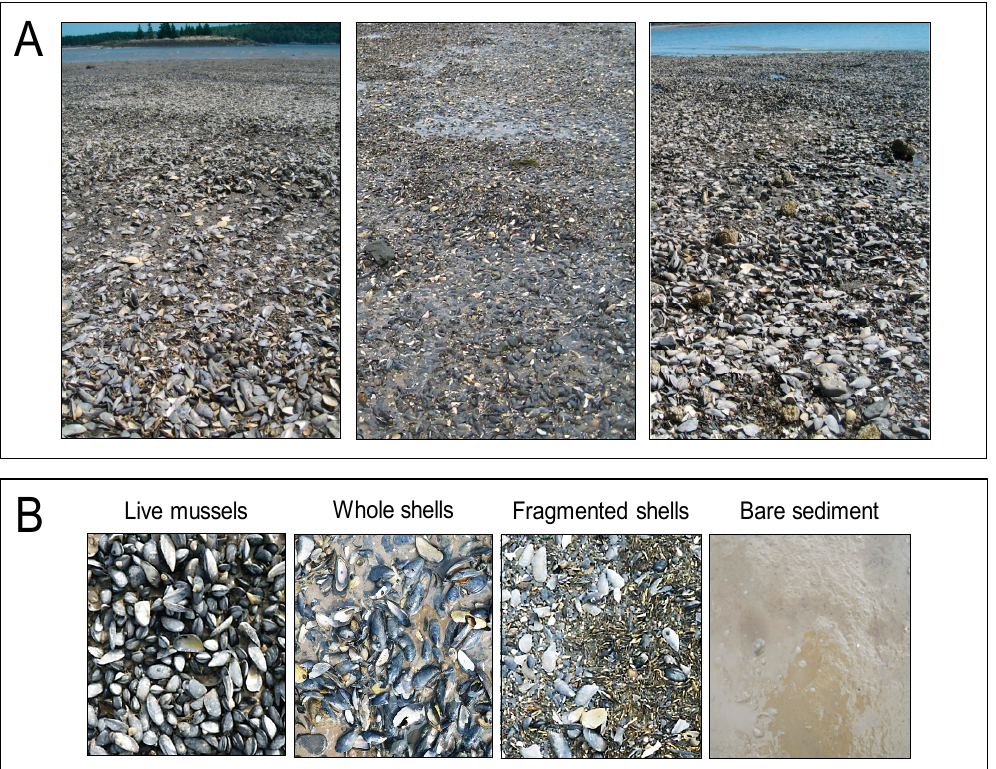
Figure 1. ( A ) Collapsed mussel beds in eastern Maine, USA. Shell hash is the primary component of the surface of the beds pictured here. ( B ) The four bottom cover types commonly observed at robust and collapsed mussel beds.